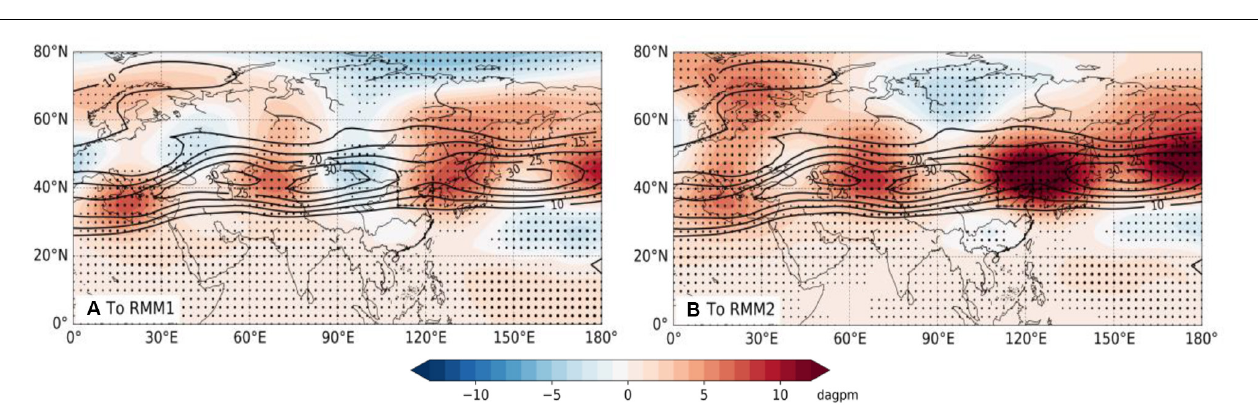
FIGURE 10 | Composites of anomalous height at 200 hPa in each phase of MJO in the summer of 2018 (the dotted areas, exceed 95% confidence level; unit: dagpm). The contour lines are the averaged zonal wind velocity u at 200 hPa in the summer of 2018. Unit: m · s − 1 . (A) The composite map of 200hPa height field anomaly (shaded areas, dotted areas passed 95% confidence level) corresponding to the phase 1-2 of MJO and the isoline is the average 200hPa westerly wind speed in summer of 2018. (B–D) The same, but corresponding to the 3-4, 5-6, 7-8 phases of MJO.